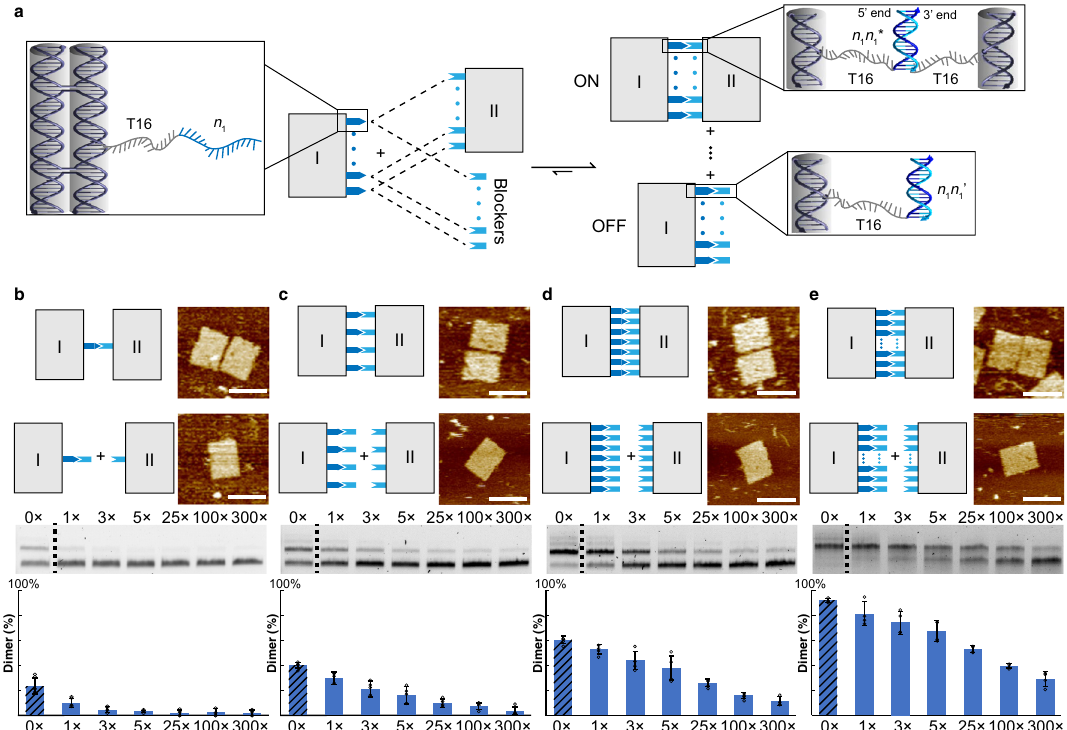
Fig. 3 ON/OFF switch of a dual-unit 2D DNA nanostructure system. a Schematic diagram of ON/OFF switch. The binding of two 24H × 26T origami units is resulted from the complementation of as many as 15 pairs of connecting staples, which can be displaced by as many as 15 blockers. Strand level of details shown in insets for different dynamic states. b – e Results with one pair of sticky ends and one blocker ( b ), four pairs of sticky ends and four blockers ( c ), seven pairs of sticky ends and seven blockers ( d ) and all 15 pairs of sticky ends and 15 blockers ( e ). Top, diagrams and corresponding AFM images (scale bars: 100 nm). Middle, agarose gel electrophoresis results without blocker (0×) and of different blocker to sticky end concentration ratios (1× to 300×); dimers as upper bands and monomers as lower bands. Bottom, yield analysis of dimer formation based on gel results for different blocker concentrations in blue histograms (yield without blocker (0×) in shaded histogram). Four independent experiments were repeated and the detailed statistics (e.g., mean and SD) in Supplementary Figs. 24 –